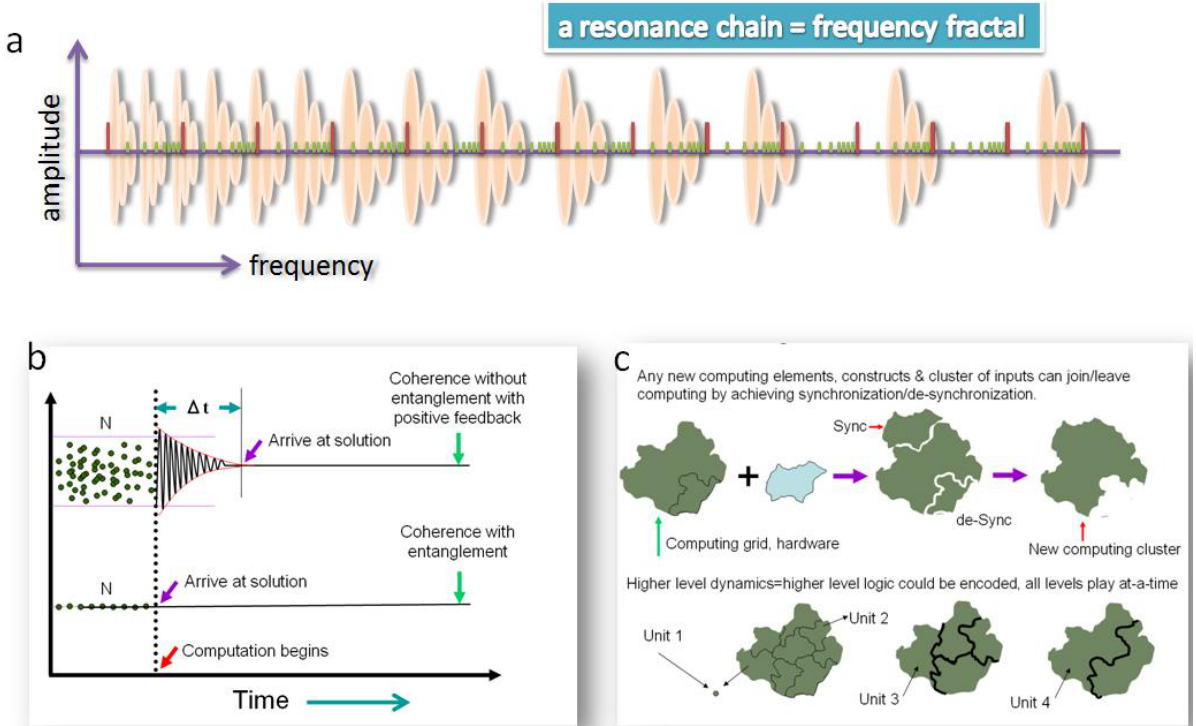
Figure 8. ( a ) Triplet band made resonance chain plotted in a Log scale; ( b ) Entanglement causes immediate collapse, however, we need spontaneous synchronization and de-synchronization hence we need time Δt, however, it includes programming; ( c ) The mechanism of fusion and fission of fractal seed networks during